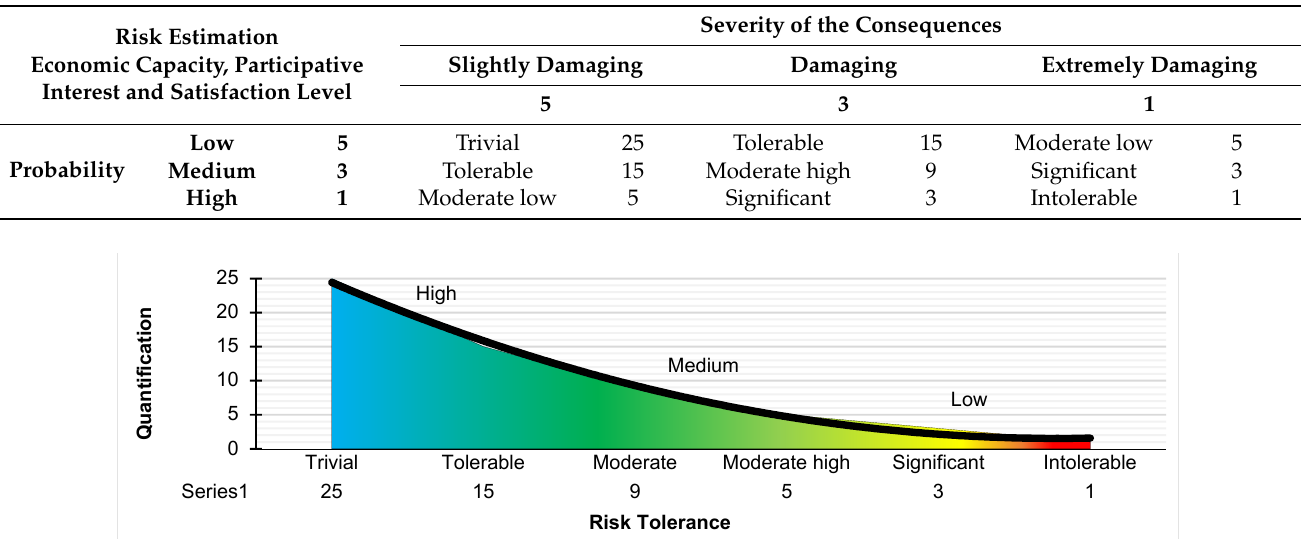
Figure 3. Characteristic values graphic: economic capacity, participative interest and satisfaction level.